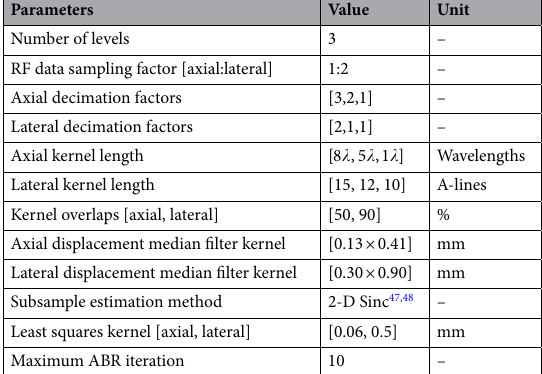
Table 2. Displacement estimation